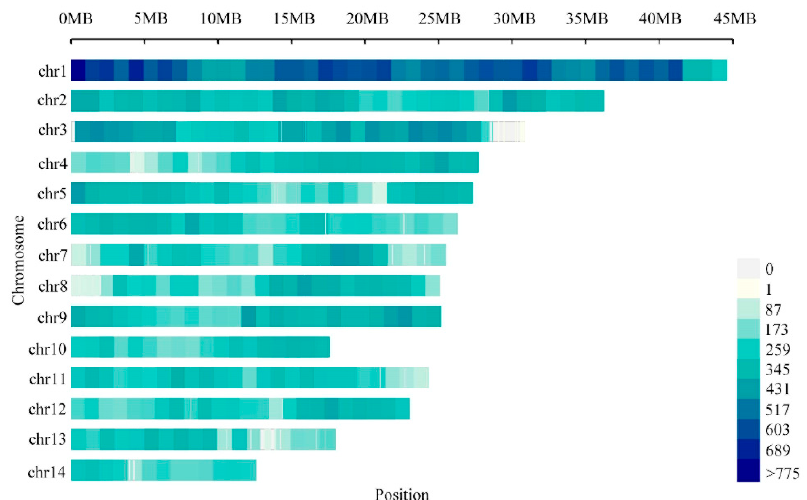
Figure 5. Overview of the high-density SSR primer pairs physical map in N. colorata . The bar represents the number of SSR primer pairs within a 1 Mb window. Table 1. Characteristics of the 13 polymorphic microsatellite loci and primer